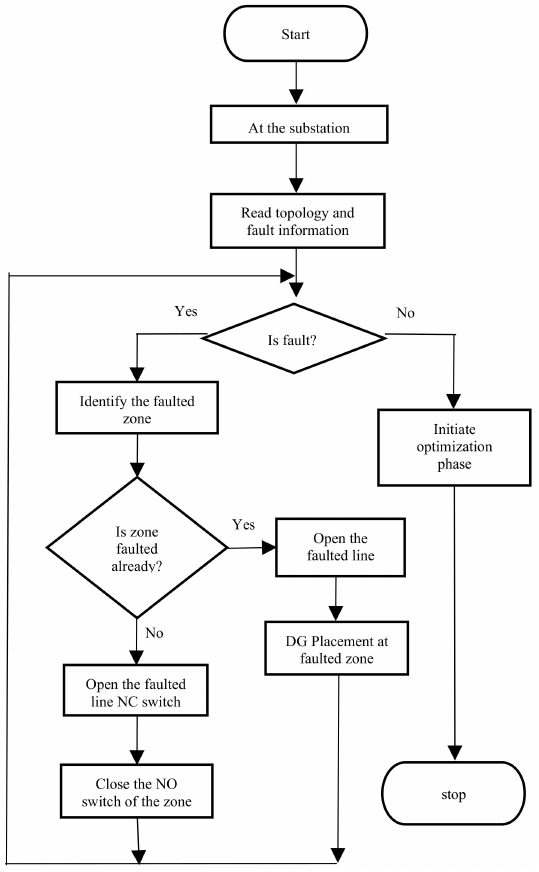
Figure 4. Service Restoration